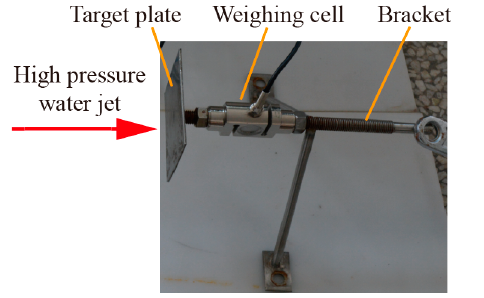
Figure 6. The detection mechanism of the water jet impact force.